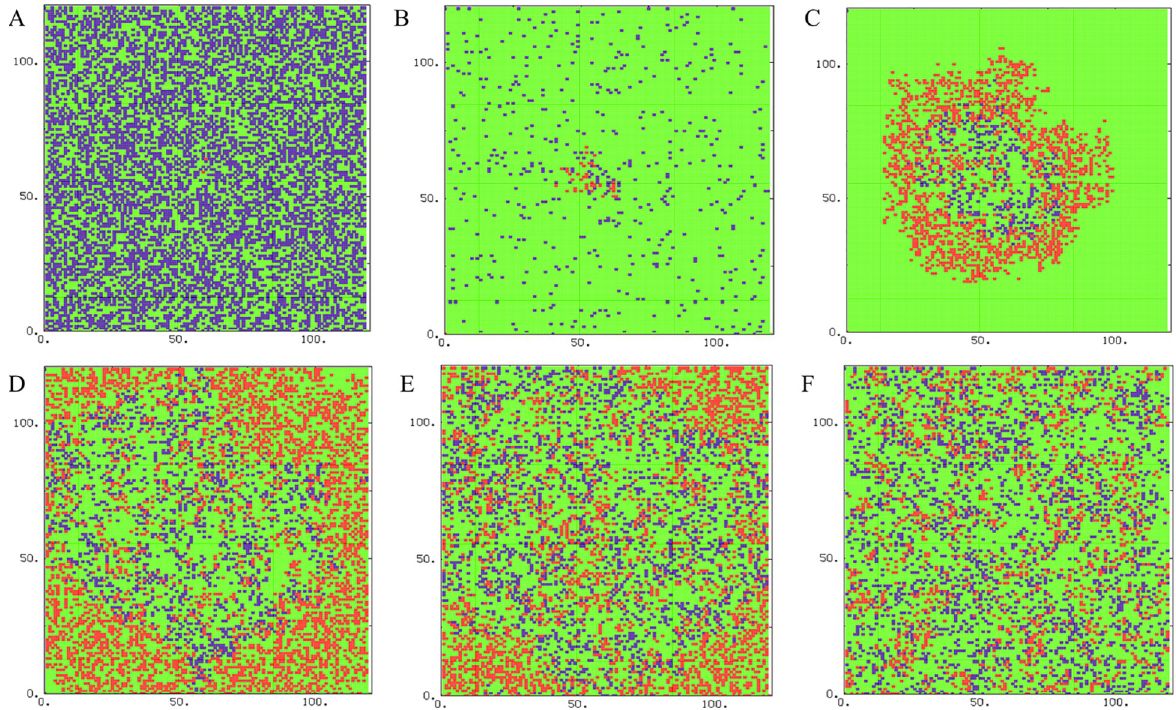
Fig 2. The snapshots of CA simulation of one sample for the set of parameters ( P I = 0.3, P T = 0.4, P H = 0.4, P D = 0.12) in different time steps; t = 1 (A), t = 20 (B), t = 60 (C), t = 100 (D), t = 120 (E), and t = 200 (F). Healthy, infected, and T cells are shown in green, red, and blue, respectively.